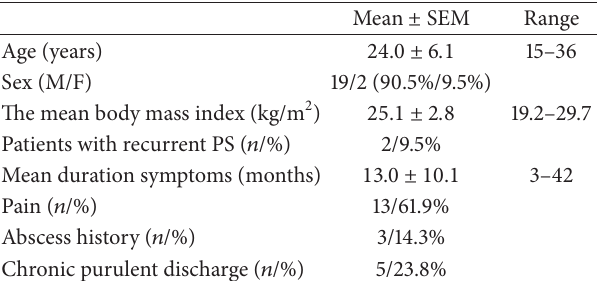
Figure 2: Flap preparation after excision of pilonidal sinus.